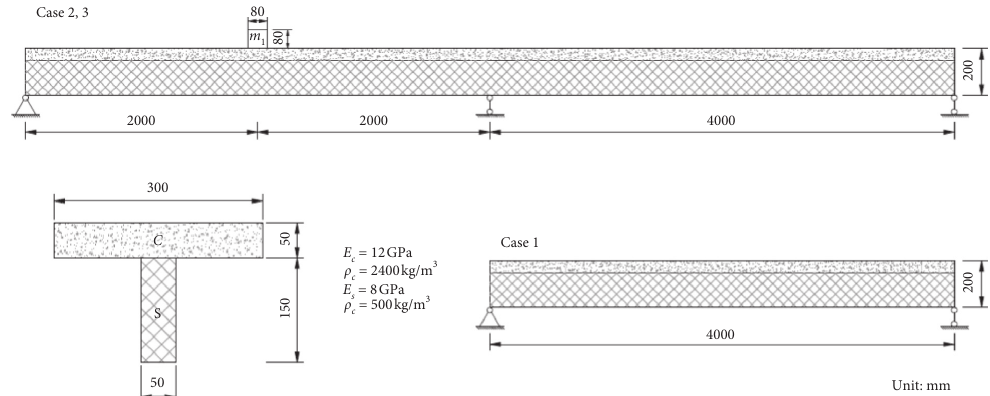
Figure 7: Cross-section dimensions and material properties (mm).